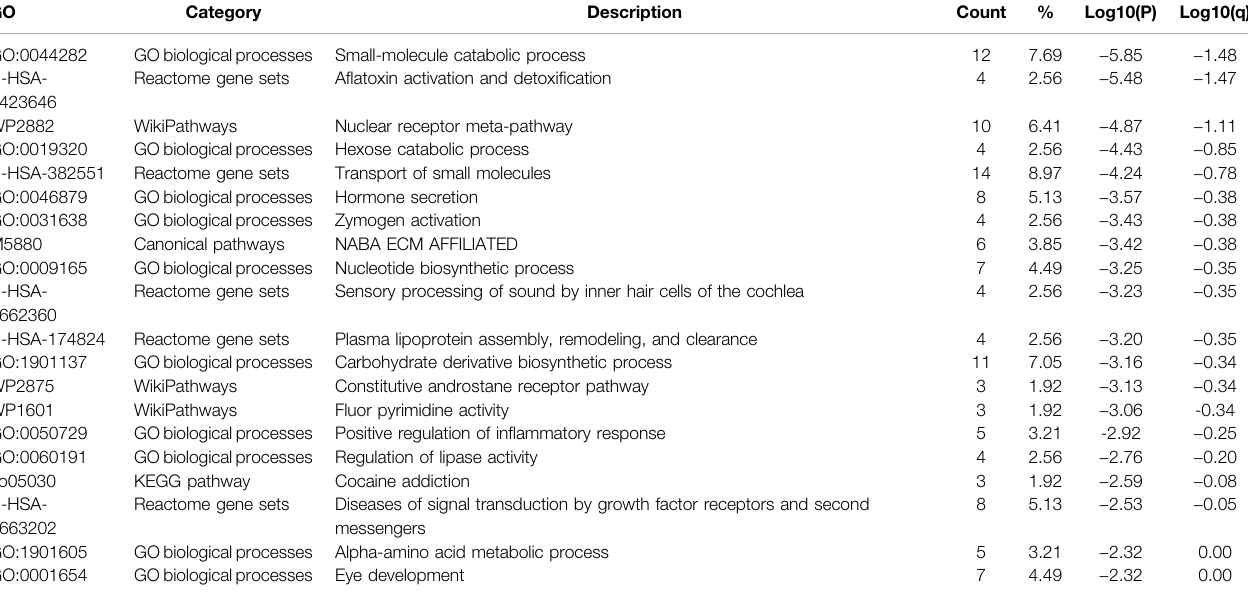
TABLE 3 | Top 20 clusters with their representative enriched terms (one per cluster).